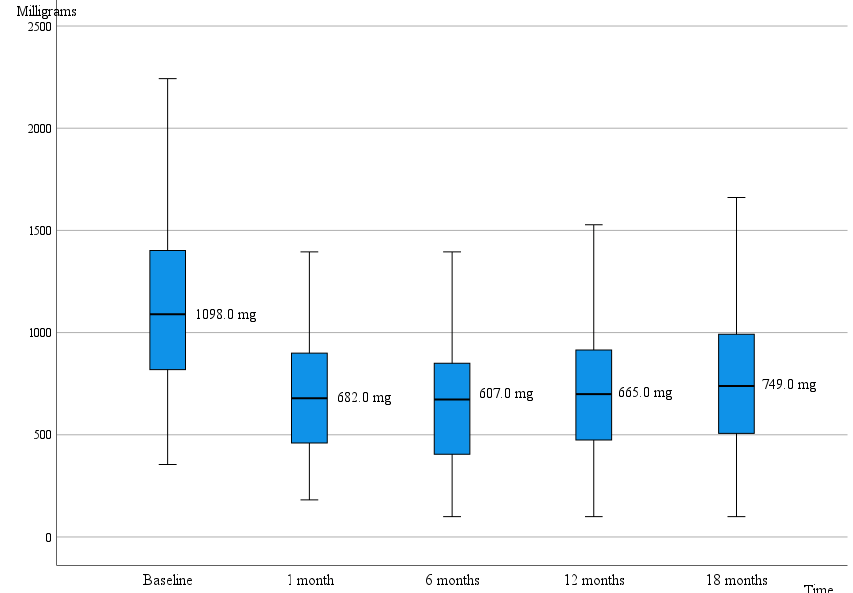
Figure 2. Median levodopa equivalent daily dosage, LEDD during the follow-up. After the 6-month inpatient programming visits, 64.8% of dDBS leads had the same electrode configuration as that after the directional survey. The majority of the alterations in electrode activation was a shift from SSA to another SSA at the same electrode contact level (in 7.2% of the dDBS leads) or a switch from directionality to omnipolarity (8.0%) at the same contact level (Figure 3). Other alterations were switching from omnidirectional stimulation to directional stimulation (7.2%) and/or from TSA stimulation to SSA (5.6%). After the 6-month visit, SSA was used in 83/125 leads, omnipolarity only in 31/125, and TSA in 11/125 (Figure 4). During the 6-month in-hospital follow-up, 106/125 (84.8%) dDBS leads were programmed in directional mode. In 19/125 (15.2%) leads, in-hospital direc- tionality testing was not performed due to sufficient symptom control with omnipolar stimulation.